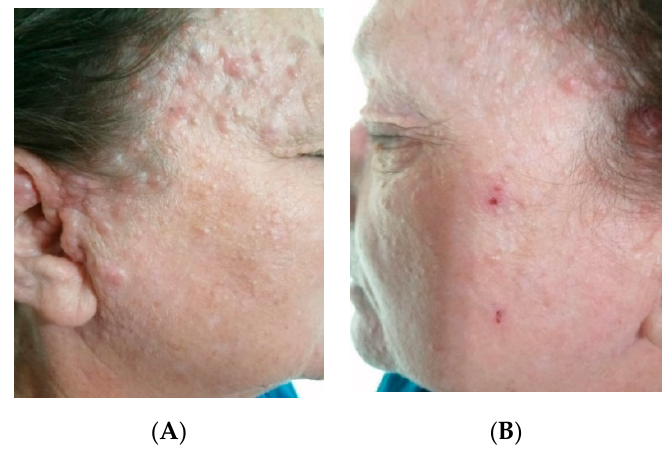
Figure 11. ( A , B ): Untreated vs. treated area with CO 2 laser.